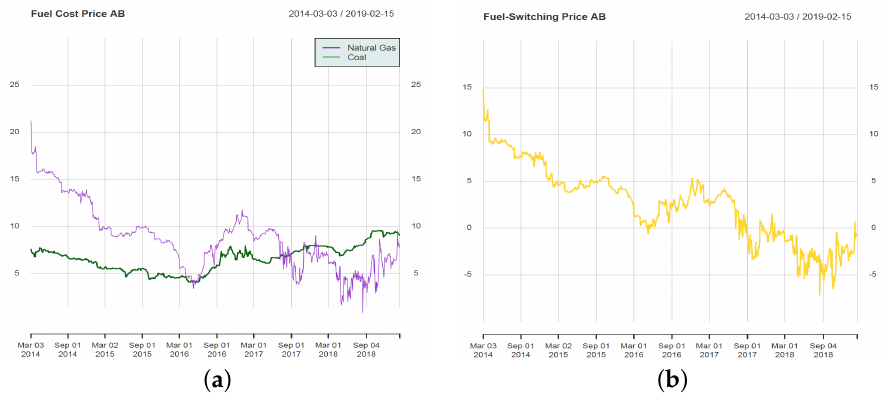
Figure 1. ( a ) The fuel cost and ( b ) fuel-switching data in Arrigoni et al. (2019), expressed in CAD/MWh.